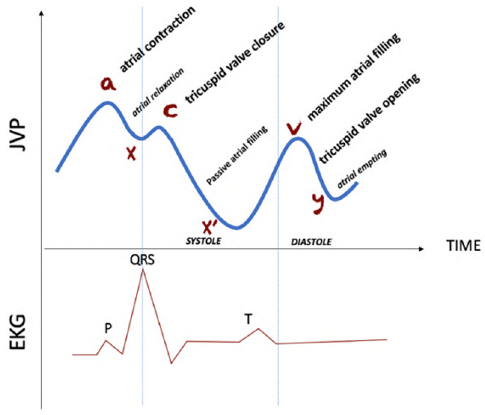
Figure 1. JVP waveform synchronized with